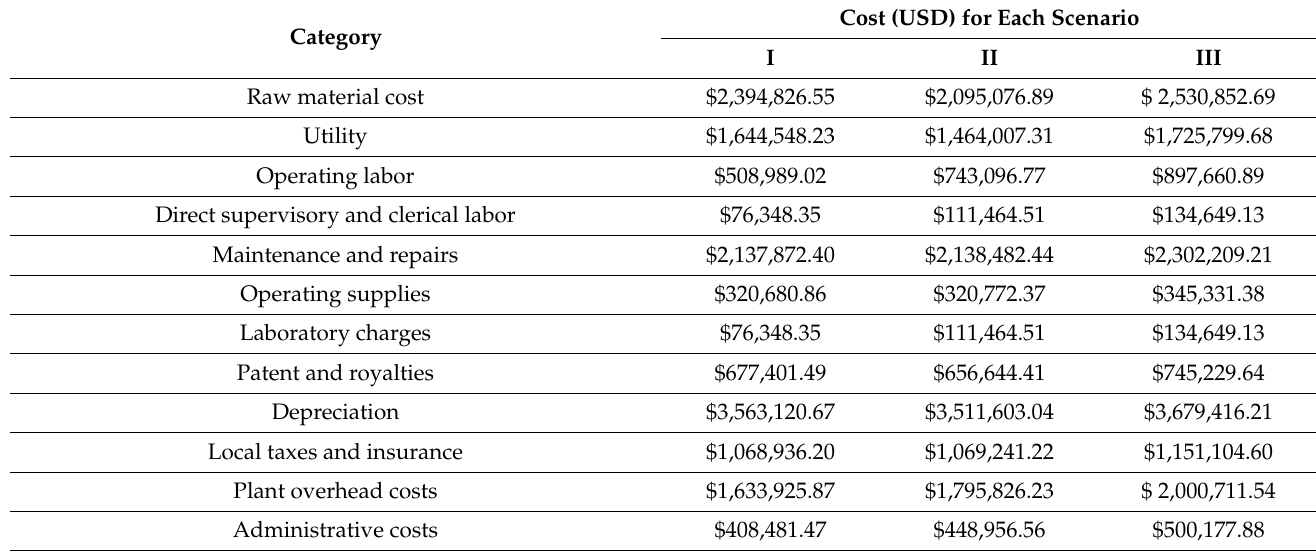
Table 2. Estimation of annual rhamnolipids production costs for each